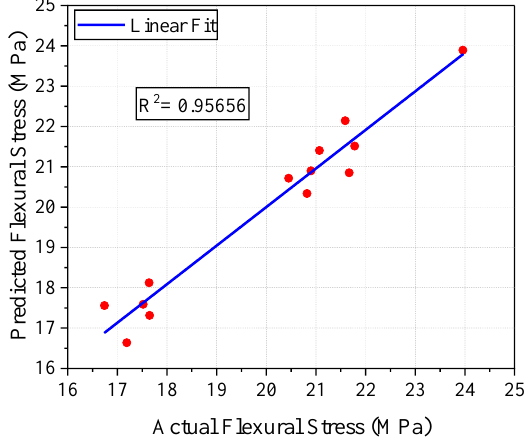
Figure 8. Regression analysis for flexural stress.